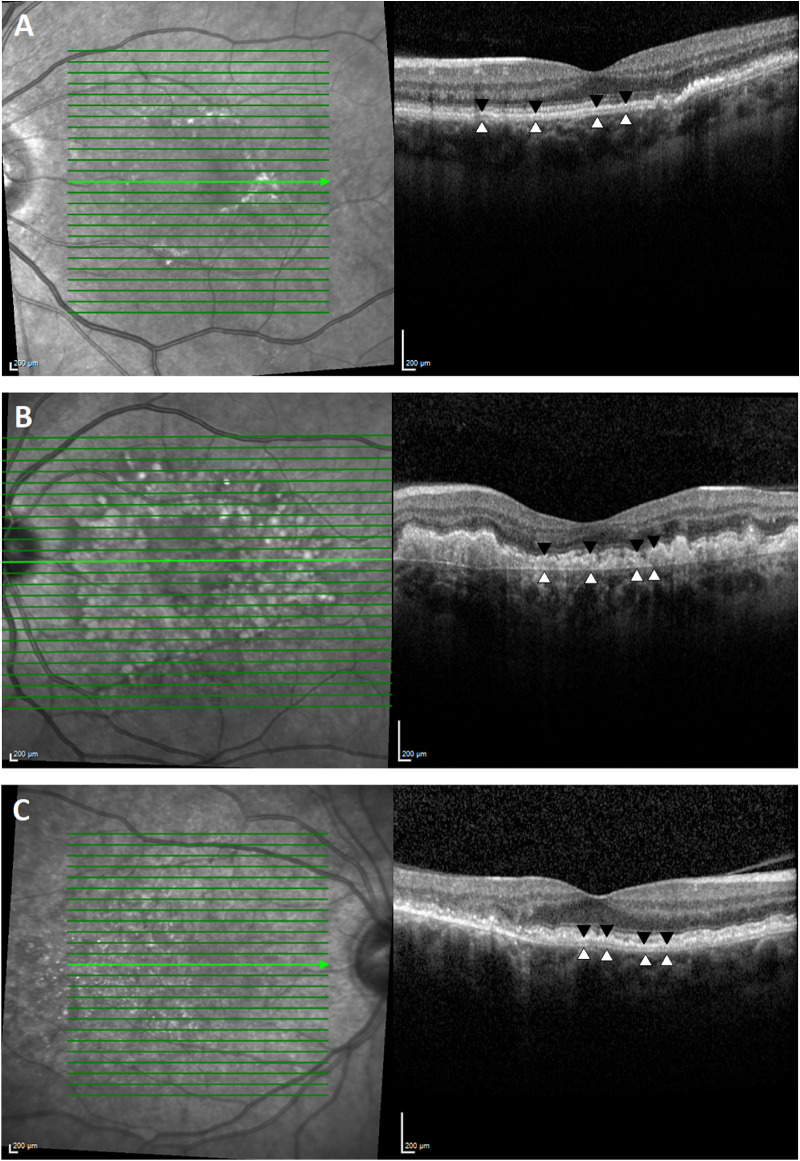
SD-OCT scans identifies distinctive separation of the RPE (black arrowheads) from BM (white arrowheads) in patients diagnosed with SFD (A), DD (B), and late-onset macular degeneration (C). The green line highlights the position of the B-scan represented in the left hand images.